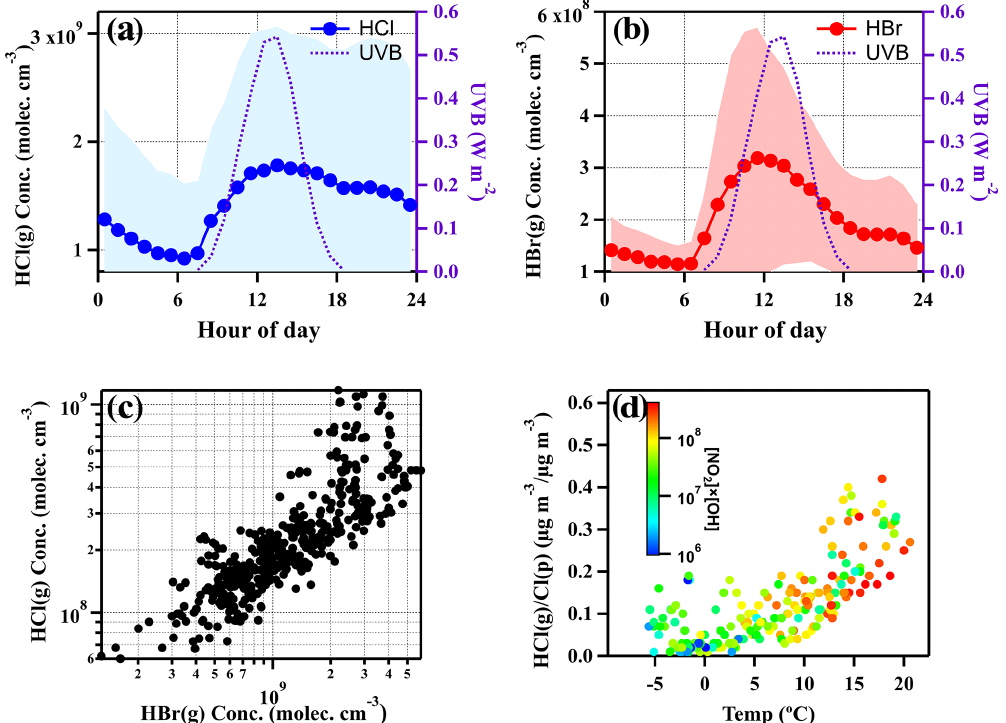
Figure 4. Diurnal variations of UVB intensities, HCl and HBr concentrations (averaged values ± one standard deviation) (a, b) and the correlation between HCl and HBr (c) . Temperature dependence of gas–particle partitioning ratios of mass concentration of chloride, color- coded by [NO 2 ] × [OH], which indicates the abundance of HNO 3 in the daytime (d) . In panel (c) and (d) , the data points are hourly averaged ones during daytime (08:00–17:00). All snowy and rainy days during the sampling period were excluded.